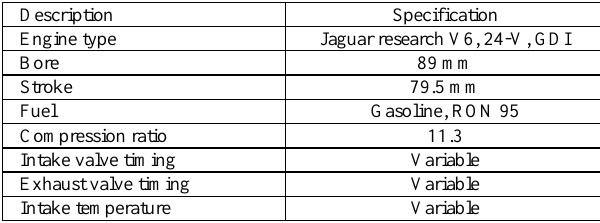
Table 1. Engine specification